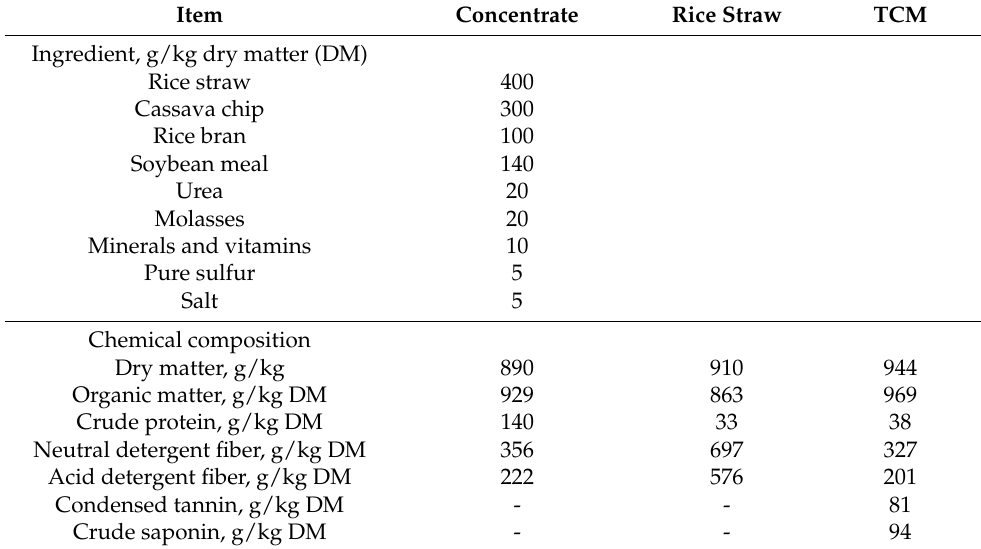
Table 1. Ingredients and chemical compositions of concentrate, rice straw, and Terminalia chebula meal